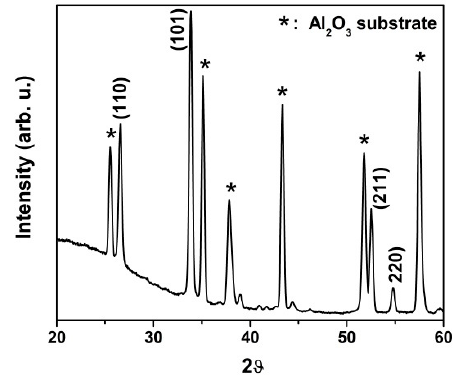
Figure 3. GI-XRD profile of SnO 2 nanowires.